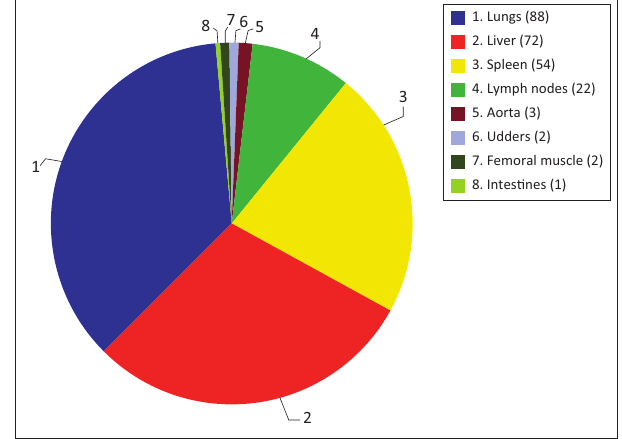
FIGURE 2: Distribution of suspicious Bovine tuberculosis lesions by organ in small ruminants (sheep and goats) and pigs at Bobo-Dioulasso